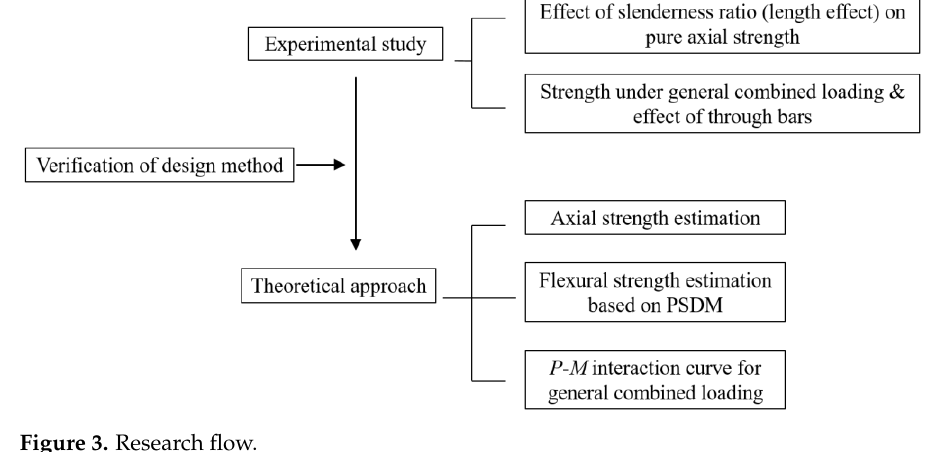
Figure 3. Research flow.